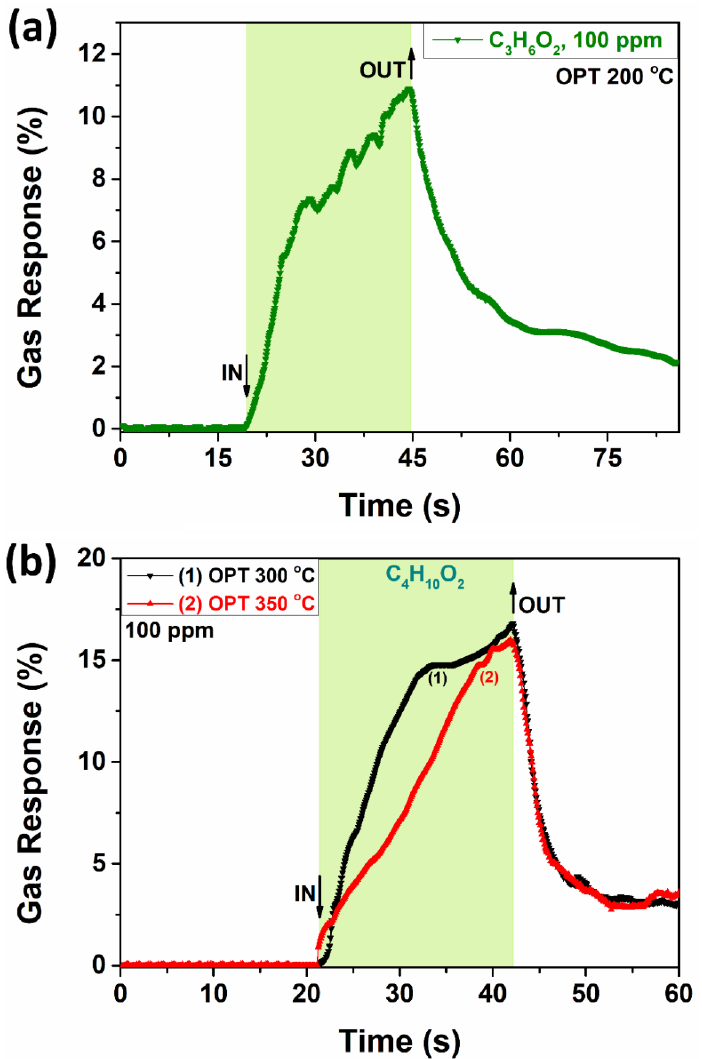
Figure 10. Dynamic curves to 100 ppm for the Al 2 O 3 /CuO-3D sensors to: ( a ) C 3 H 6 O 2 ; and ( b ) C 4 H 10 O 2 vapor at two different operating temperatures.